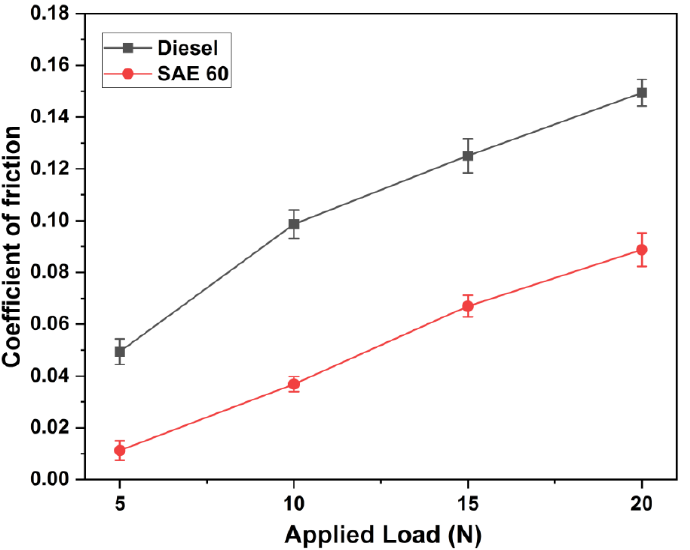
Figure 12. Effect of applied load on coefficient of friction in wet condition for Al-CNT-Sn specimens with 1.0 wt. % CNT.